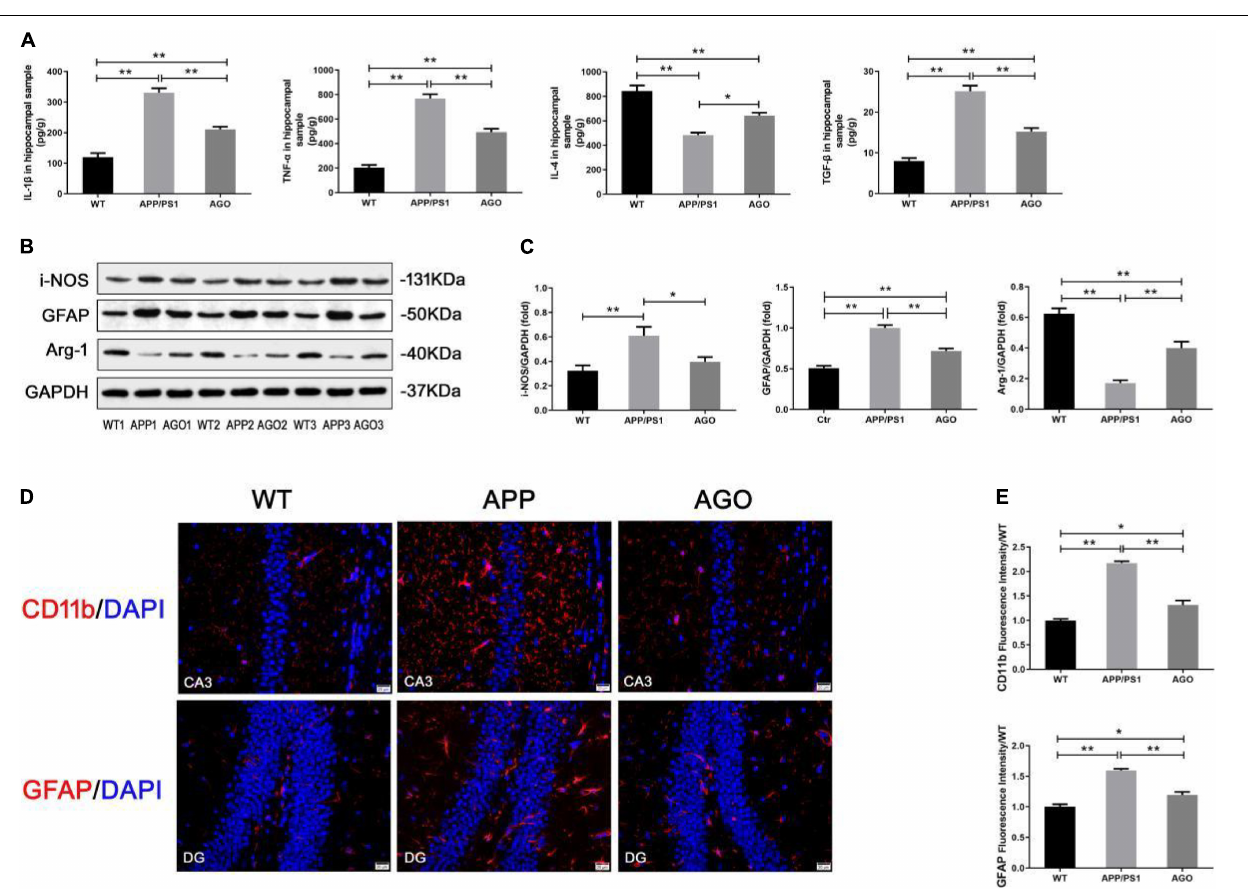
FIGURE 4 | Effect of agomelatine on neuroinflammation in APP/PS1 mice. In the agomelatine-treated group, mice were intraperitoneally injected with agomelatine (50 mg/kg/day) for 30 days. (A) Measurement of IL-1 β , TNF- α , IL-4, and TGF- β by ELISA ( n = 5). (B,C) Measurement of i-NOS and arginase-1 by Western blot ( n = 5). (B–E) Measurement of CD11b and GFAP by Western blot ( n = 5) and immunofluorescence (400 × , scale bars = 20 µ m) ( n = 3). Values are represented as the mean ± SEM. * P < 0.05; ** P <